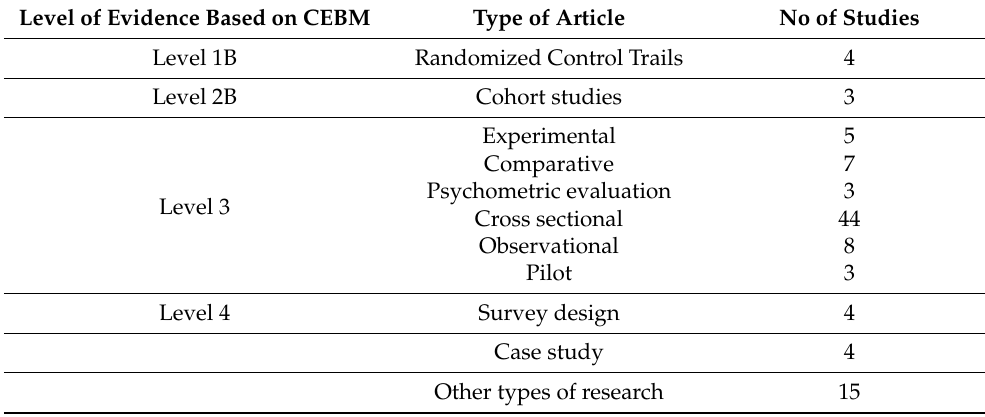
Table 9. Level of evidence of the top 50 cited articles in WMSDs in regard to RULA and NMQ. Level of Evidence Based on